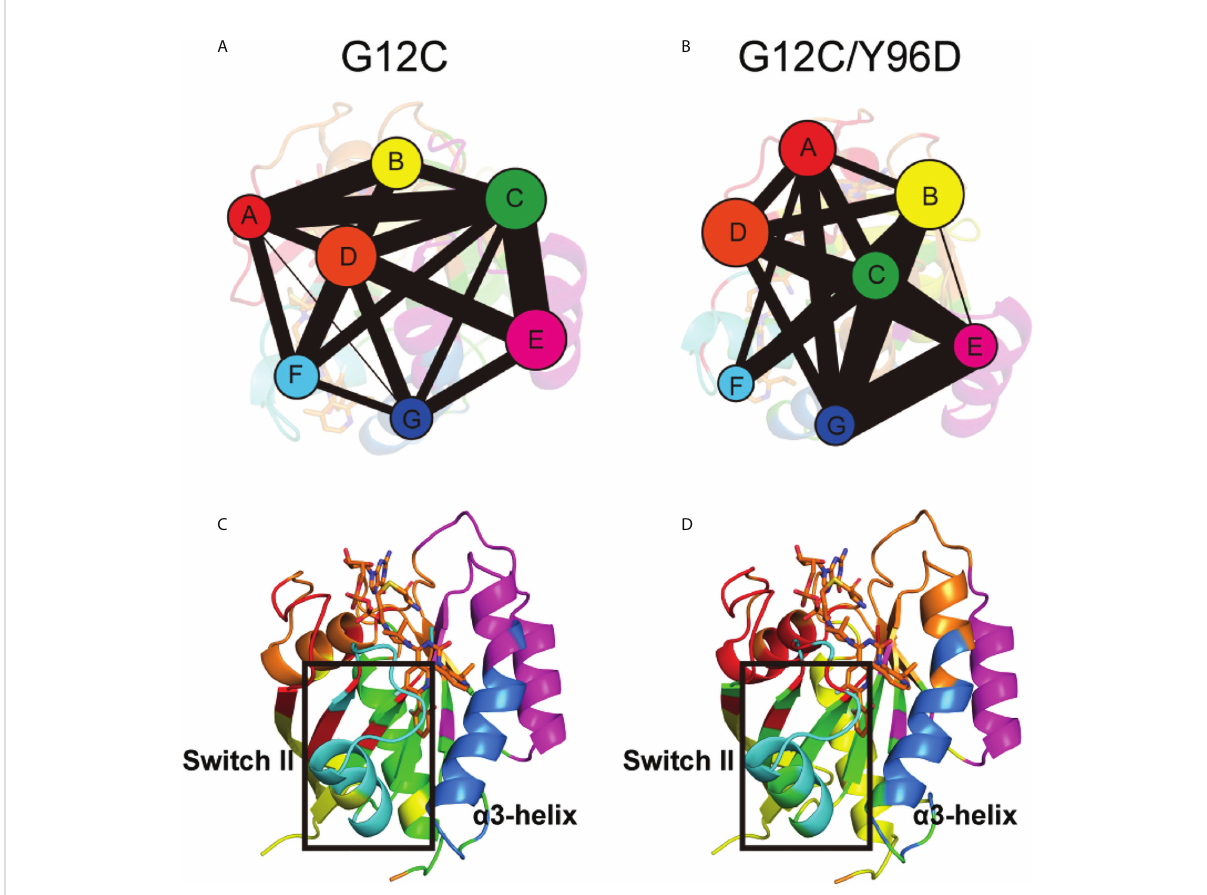
FIGURE 6 Community network of the KRAS protein. The community network in the G12C system (A) and the G12C/Y96D system (B) . Areas of the circles represent the numbers of residues in corresponding communities, and the widths of sticks connecting communities represent the intercommunity connections. Community composition in the G12C system (C) and the G12C/Y96D system (D) . The color of each community corresponds to (A, B)